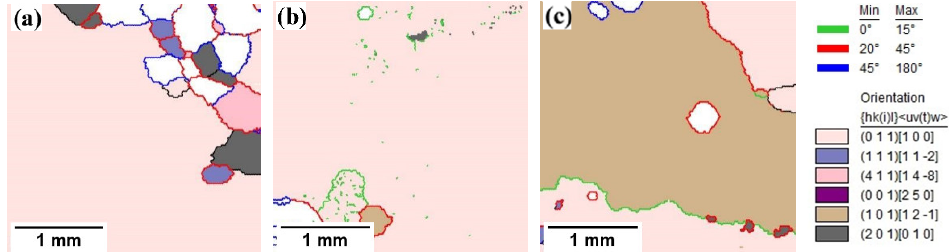
Figure 8. Grain boundaries of finally annealed samples in different atmospheres: ( a ) 100%H 2 ; ( b ) 25%H 2 + 75%N 2 ; ( c ) 50%N 2 + 50%H 2